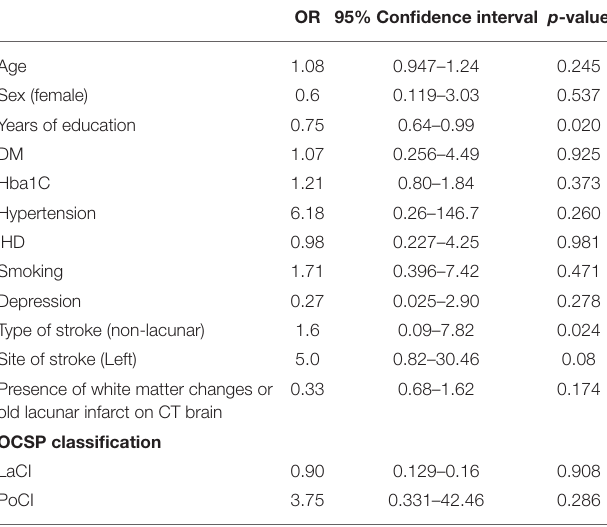
TABLE 3 | Univariate logistic regression for risk factors for dementia at 6 th month.